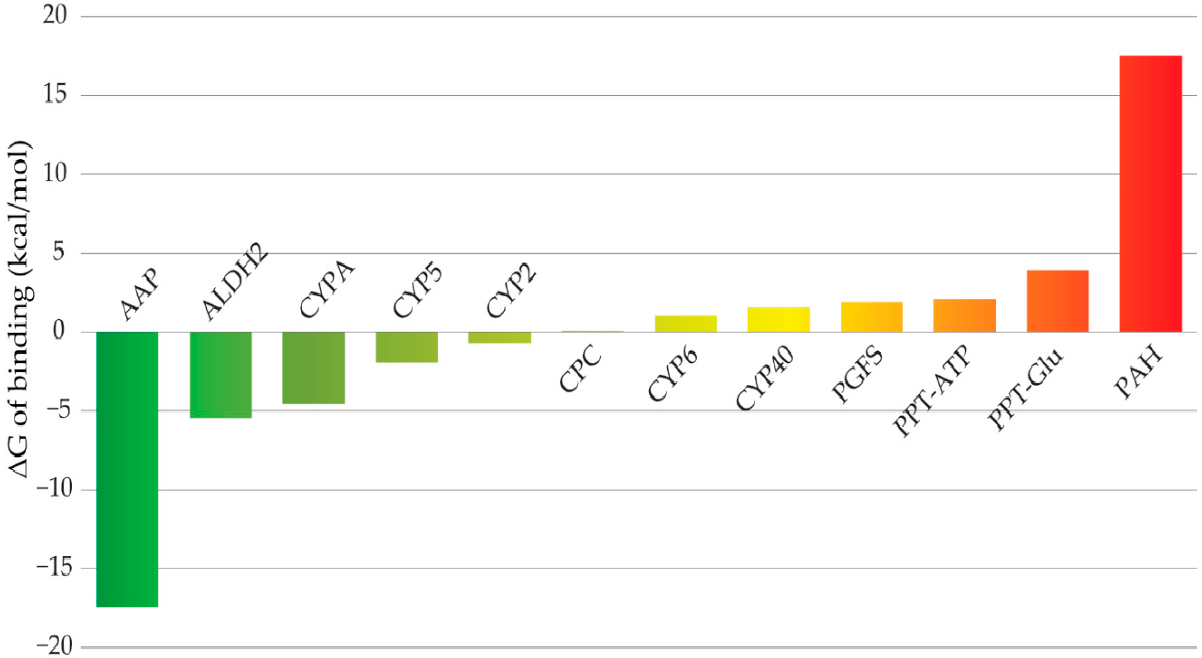
Figure 2. Predicted free energies of the binding of compound 32 to its potential targets in L. infantum .